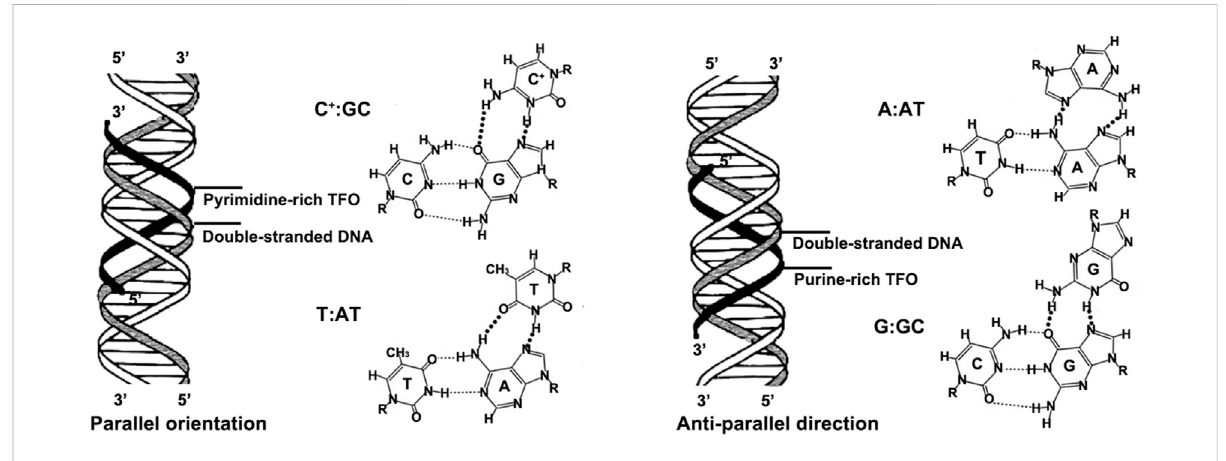
FIGURE 1 Triplex binding code in the pyrimidine-rich and purine-rich TFO